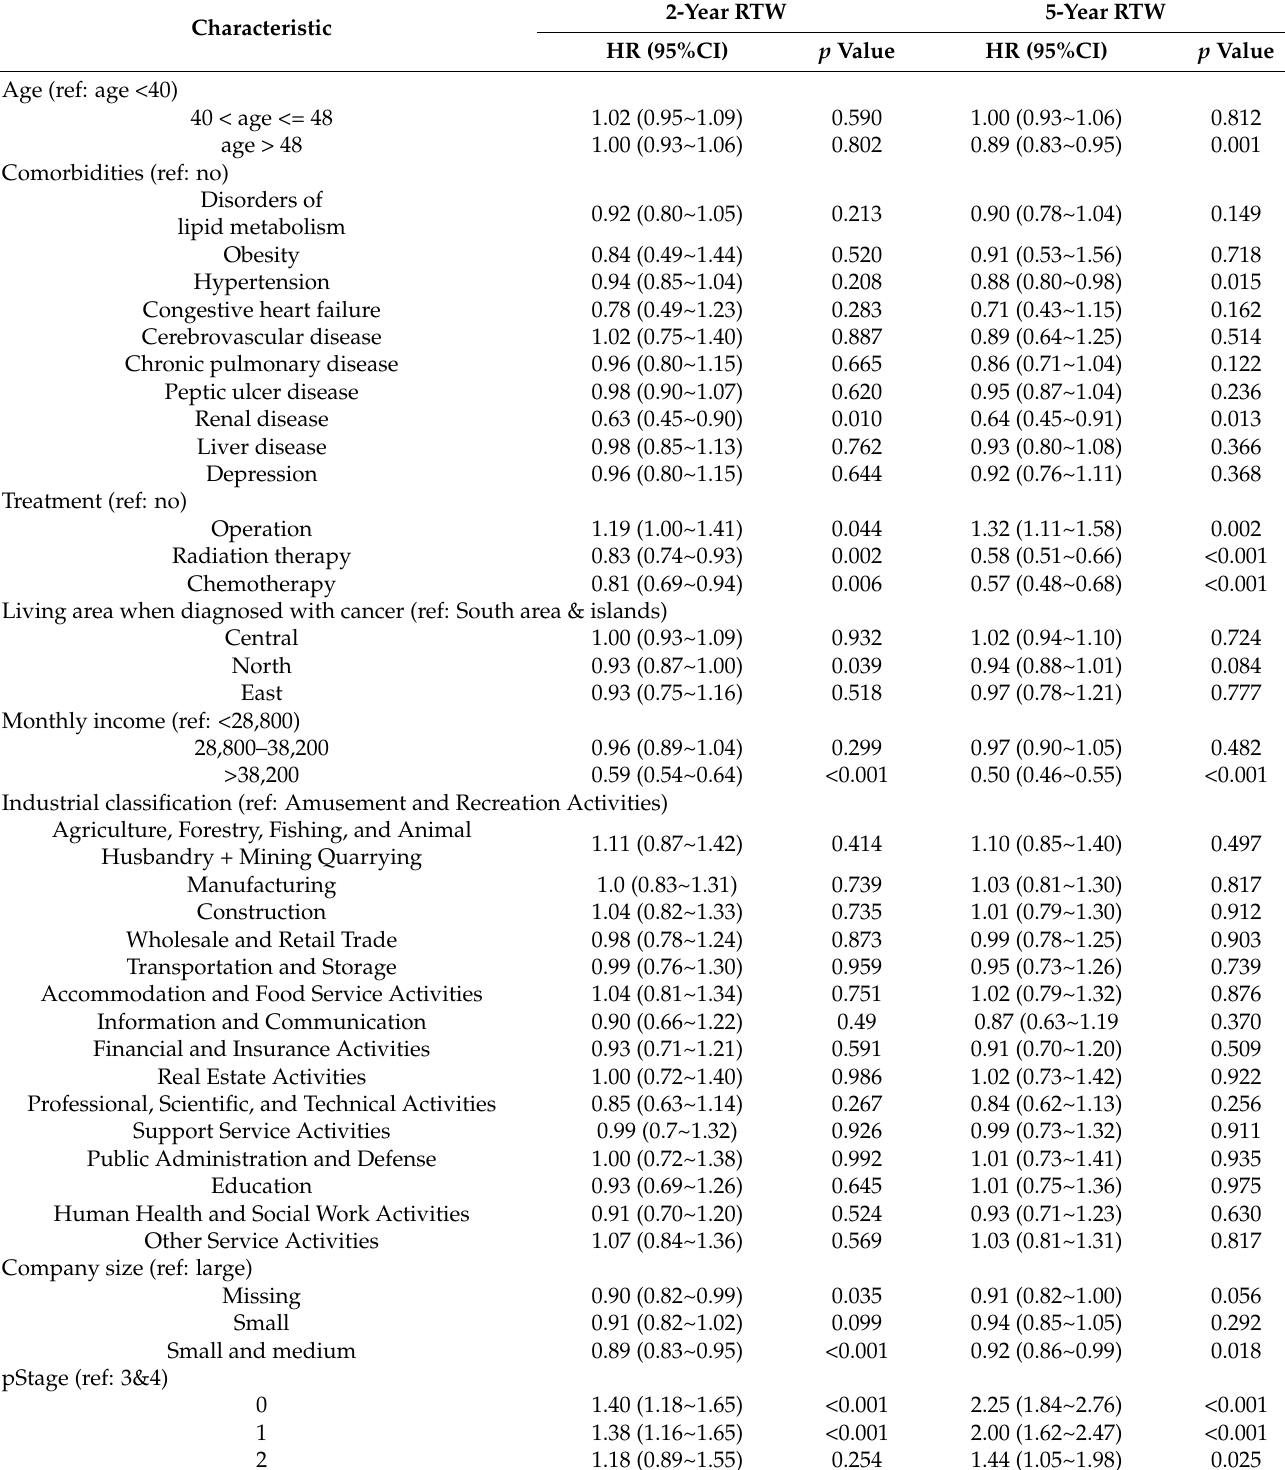
Table A1. Univariate association between independent variables and RTW of cervical cancer workers.